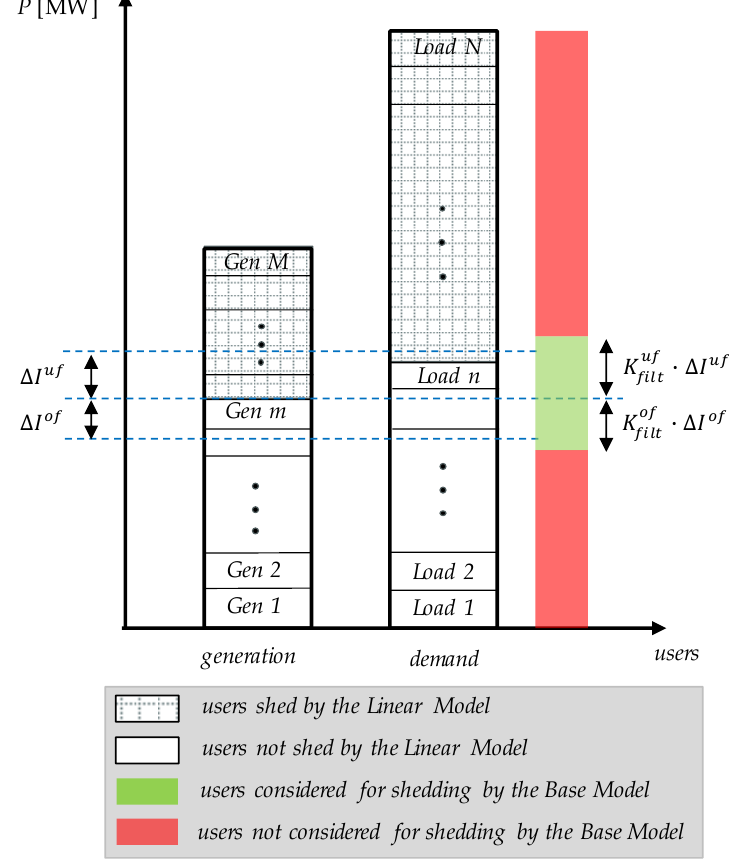
Figure 6. Illustration of the Filtering Procedure.